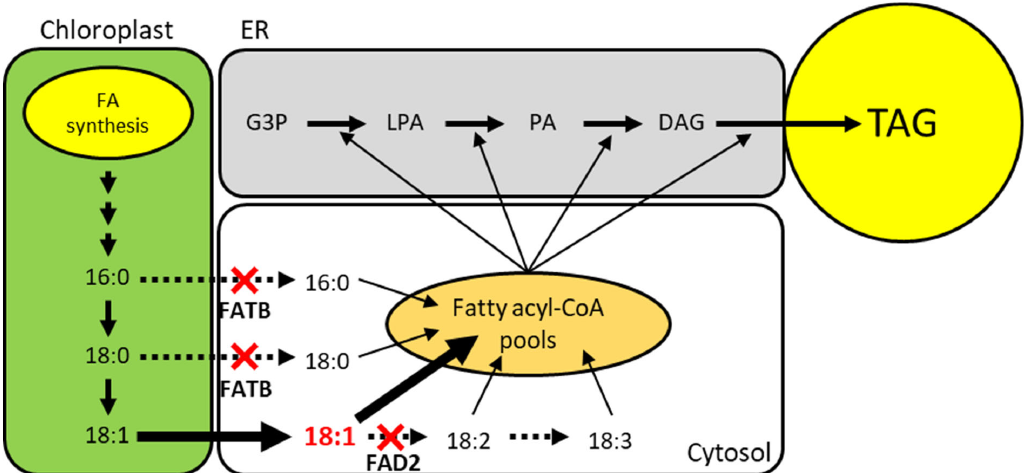
Figure 5. Schematic pathway of plant TAG biosynthesis and strategy to increase oleic acid and decrease saturated fatty acids. FAD2 and FATB knockout are indicated by red cross. Expected flux of fatty acid is depicted with arrows. The amount of flux is indicated by the thickness or type of the arrow. G3P; Glycerol-3-Phosphate, LPA; Lysophosphatidic Acid, PA; Phosphatidic Acid, DAG; Diacylglycerol, TAG; Triacylglycerol.